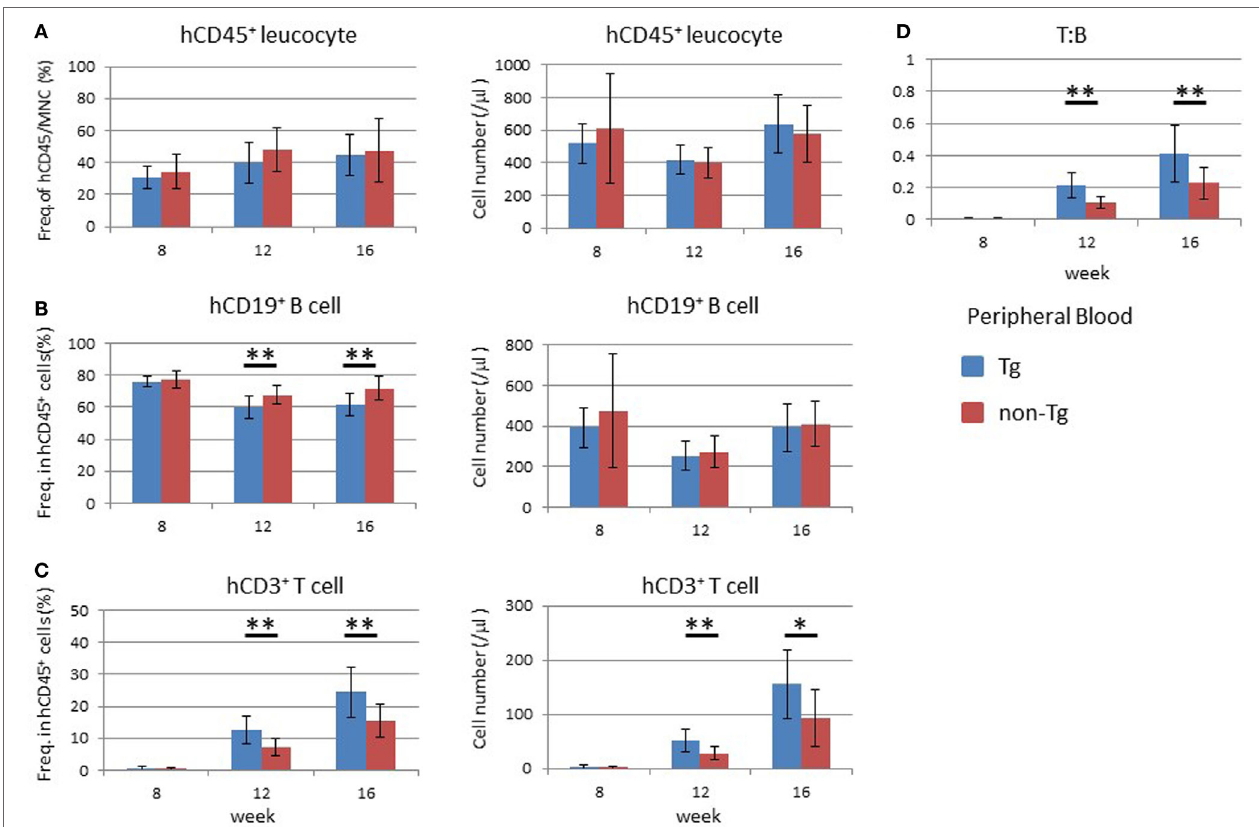
FigUre 4 | Development of human leukocytes in NOG-pROR γ t- γ c Tg mice. Peripheral blood (PB) was collected at the indicated time points after hematopoietic stem cell transfer. A portion was used for enumeration of total mononuclear cells. The remaining blood was subjected to fluorescence-activated cell sorter (FACS) for human leukocytes. (a) Frequency and absolute number of human CD45 + cells in total mononuclear cells. (B,c) Frequencies and absolute numbers of human B (B) and human T (c) cells among human CD45 + cells. Cellularity was calculated by multiplying the number of total mononuclear cells by the frequencies of each human subpopulation determined by FACS. (D) Kinetic change of the human T to B cell ratio. Mean ± SD from NOG-pROR γ t- γ c Tg ( n = 12) and NOG non-Tg mice ( n = 11). Student’s t -test was performed to assess statistical significance (* p < 0.05 and ** p < 0.01). A representative result from three independent experiments is